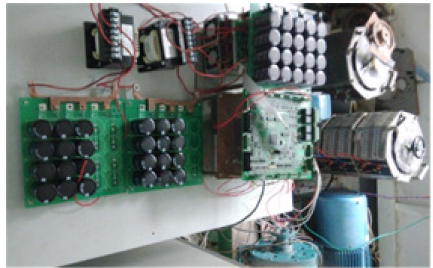
Figure 14. A picture of the experimental system.